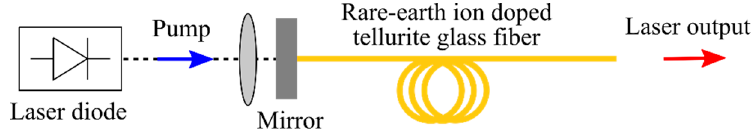
Figure 1. Variant of experimental fiber laser scheme with forward diode pumping using a mirror at the input end and only the fiber end (with Fresnel reflection) at the output as a cavity.